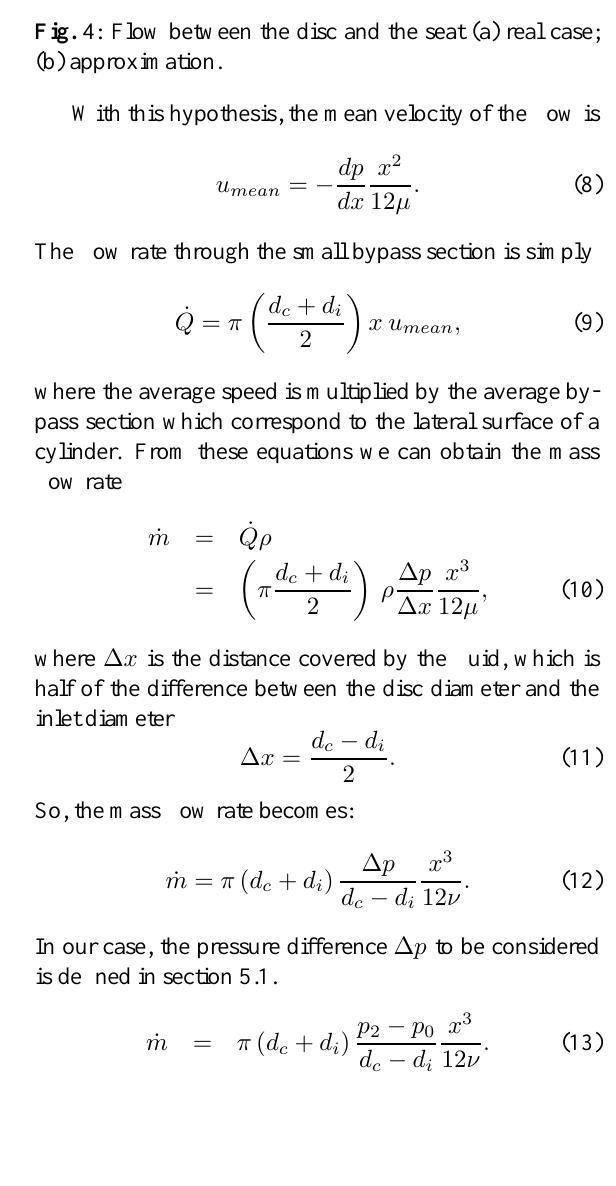
Fig. 3: Forces on the central disc